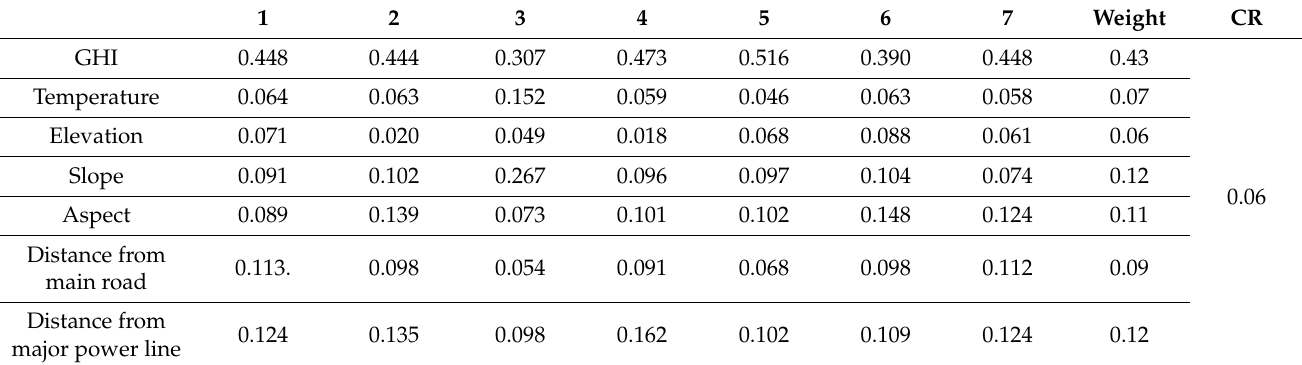
Table 4. Pairwise comparison matrix, the weights allocated to each criterion, and the consistency ratio (CR).